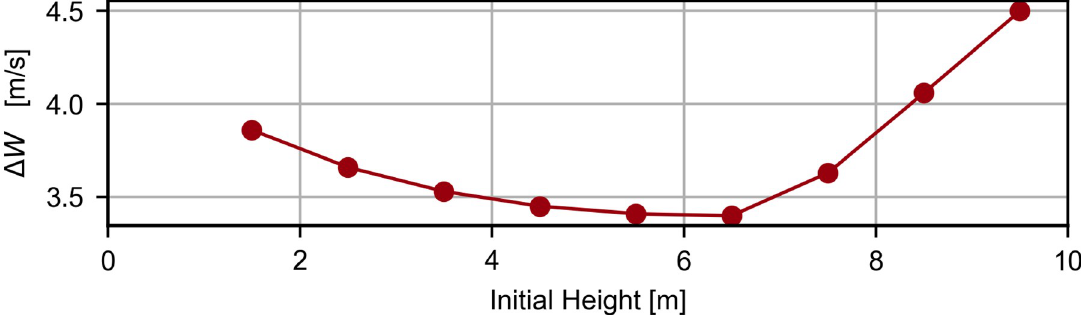
Fig 11. Effect of the initial height. Evolution of the required wind speed as a function of the initial height for a step-wind profile with b = 10 and k = 0.5.